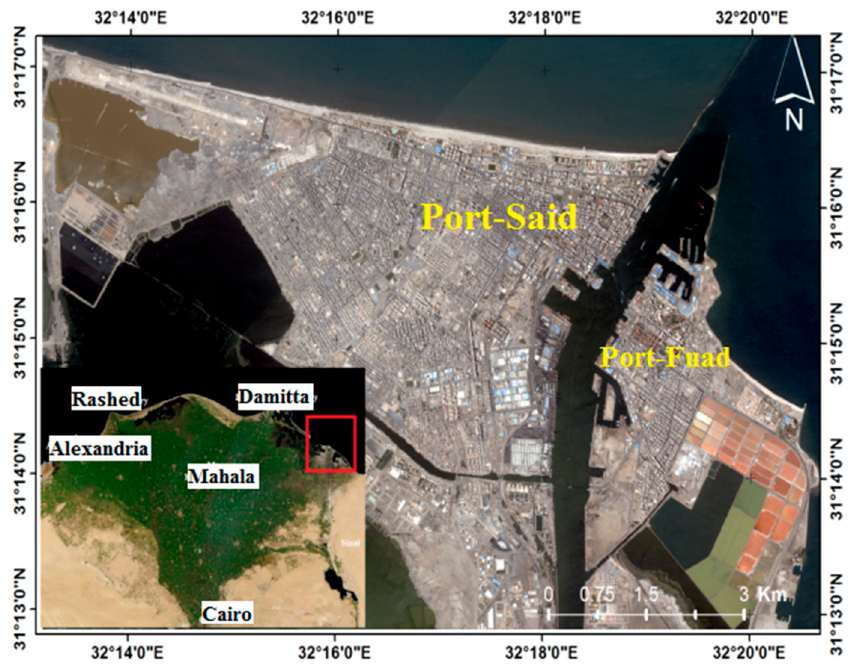
Figure 3. High spatial resolution WorldView-2 image of Port-Said and Port-Fuad.